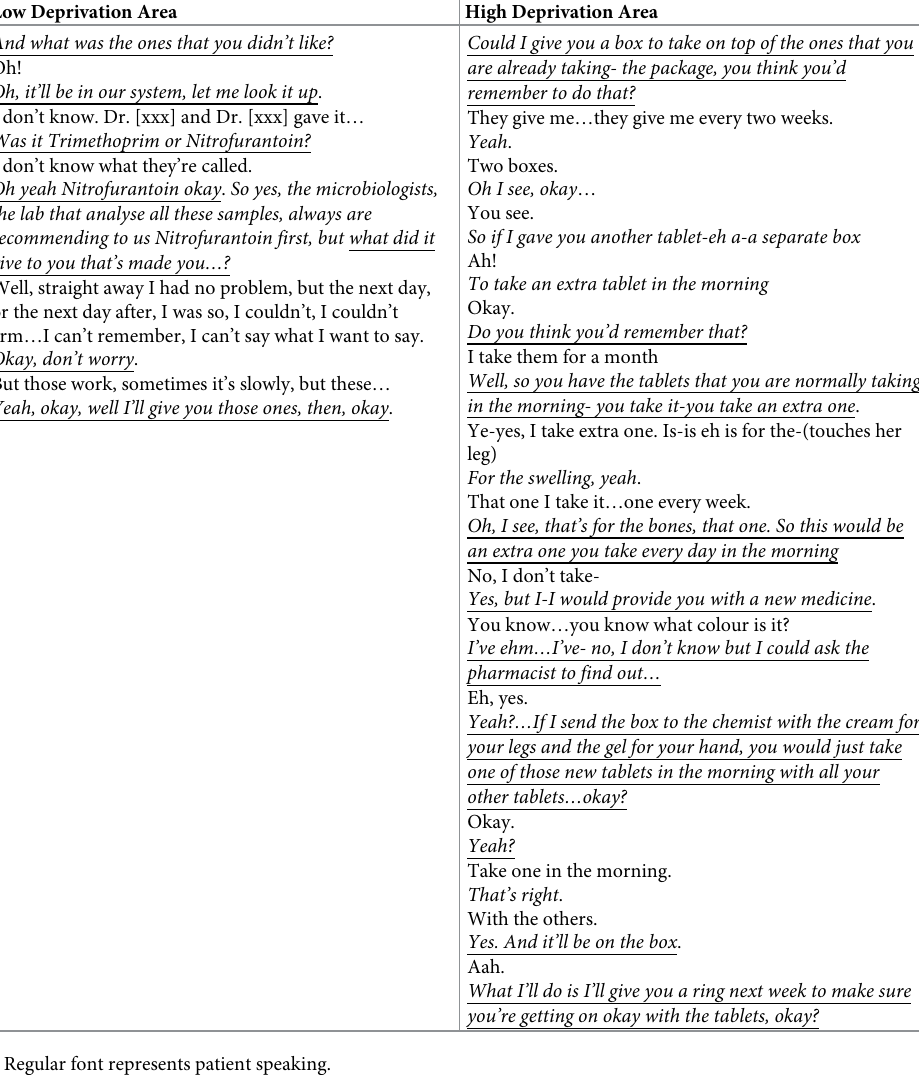
Table 4. Examples of conversations where the patients misunderstand health information. Low Deprivation Area High Deprivation